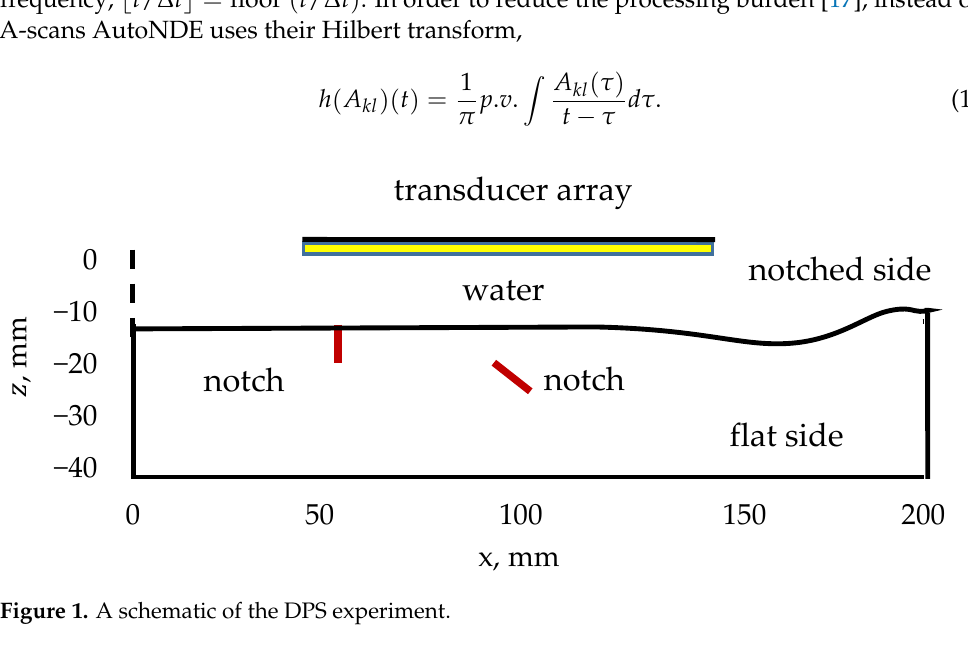
Figure 1. A schematic of the DPS experiment.